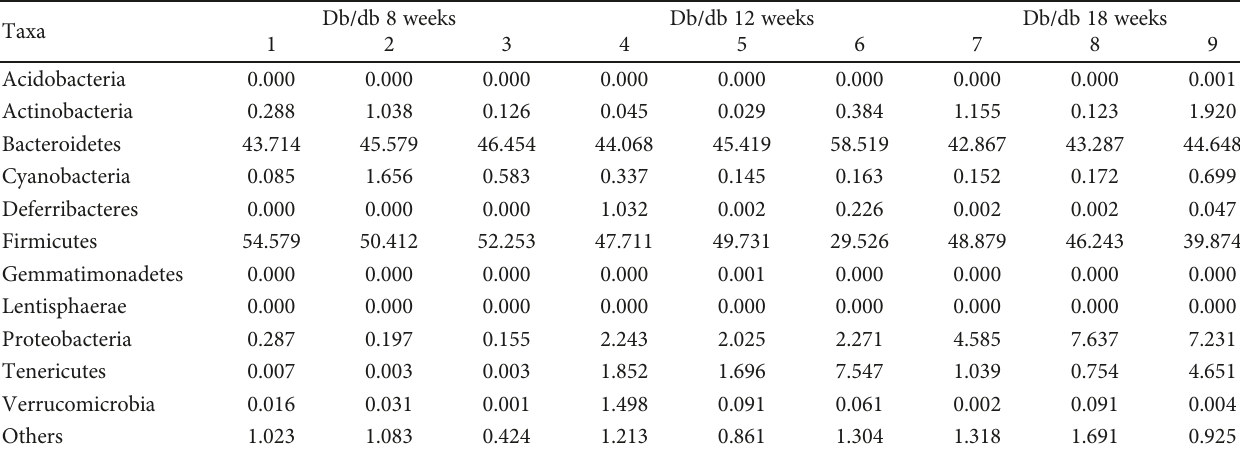
Table 2: Relative abundance in the percentage of the major OTUs at the phyla level in the fecal sample from db/db mice. Db/db 8 Taxa